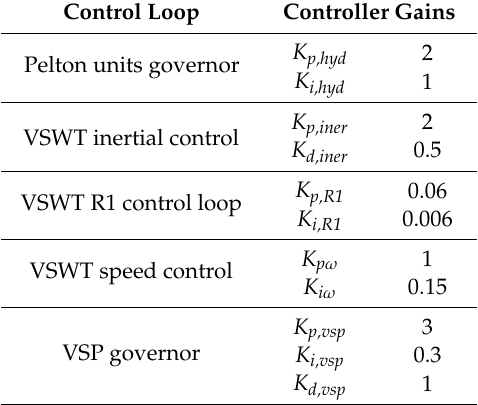
Table A2. Controllers’